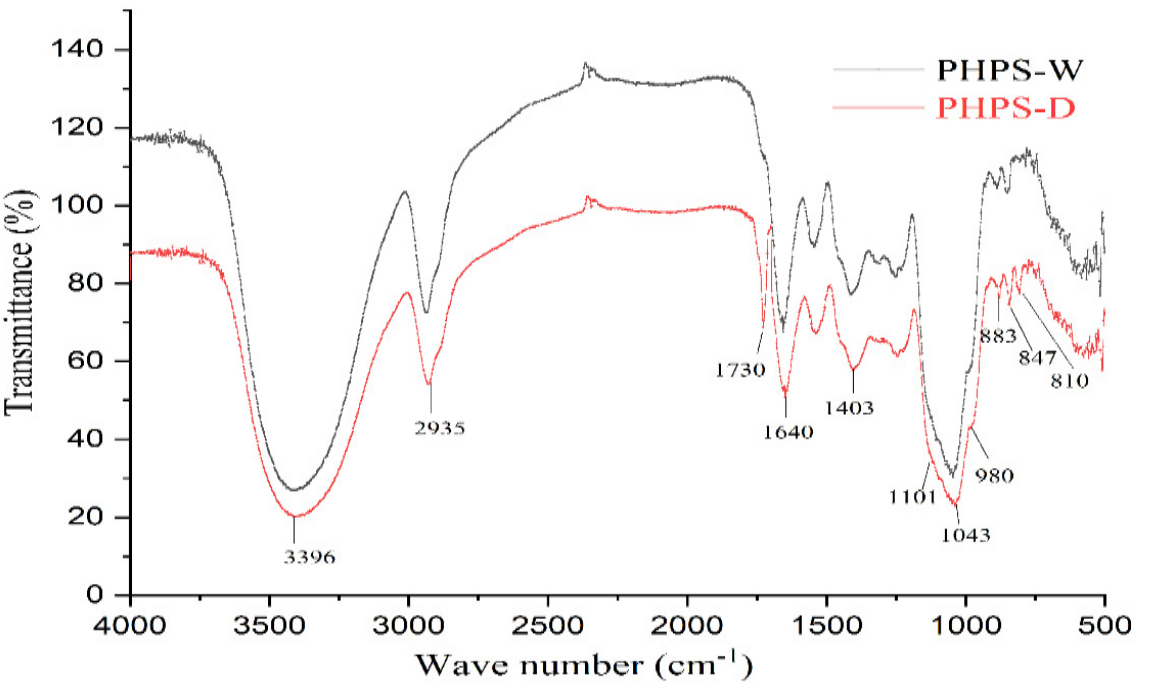
Figure 6. FT-IR spectra of PHPS-D and PHPS-W detected in the range of 4000–400 cm − 1 at 4 cm − 1 resolution.